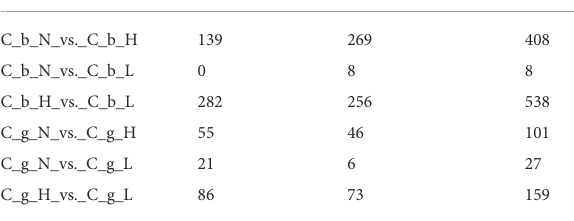
TABLE 1 Statistical analysis of differentially expressed